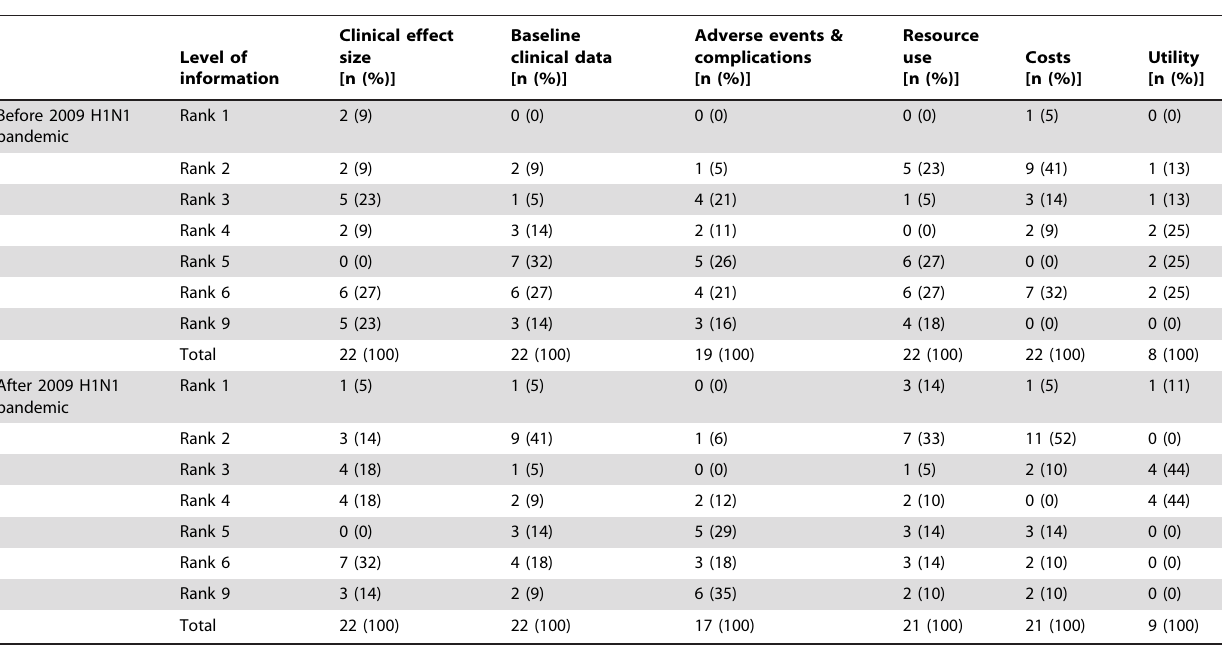
Table 4. Quality of evidence used in the 44 economic evaluations included in the